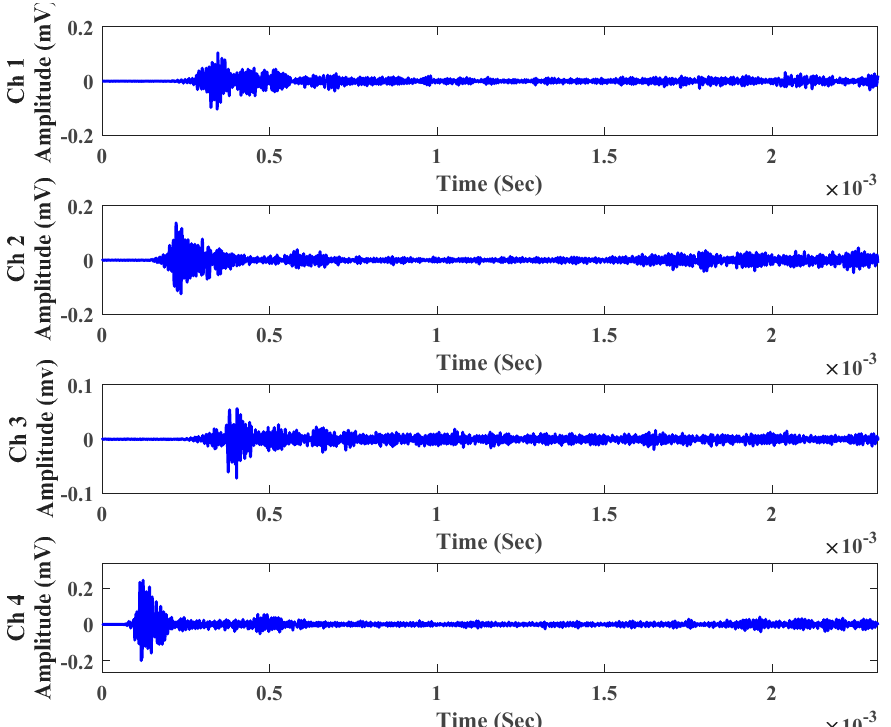
Figure 15. Acoustic emission signals obtained from the pencil lead break test (PLB) 4.